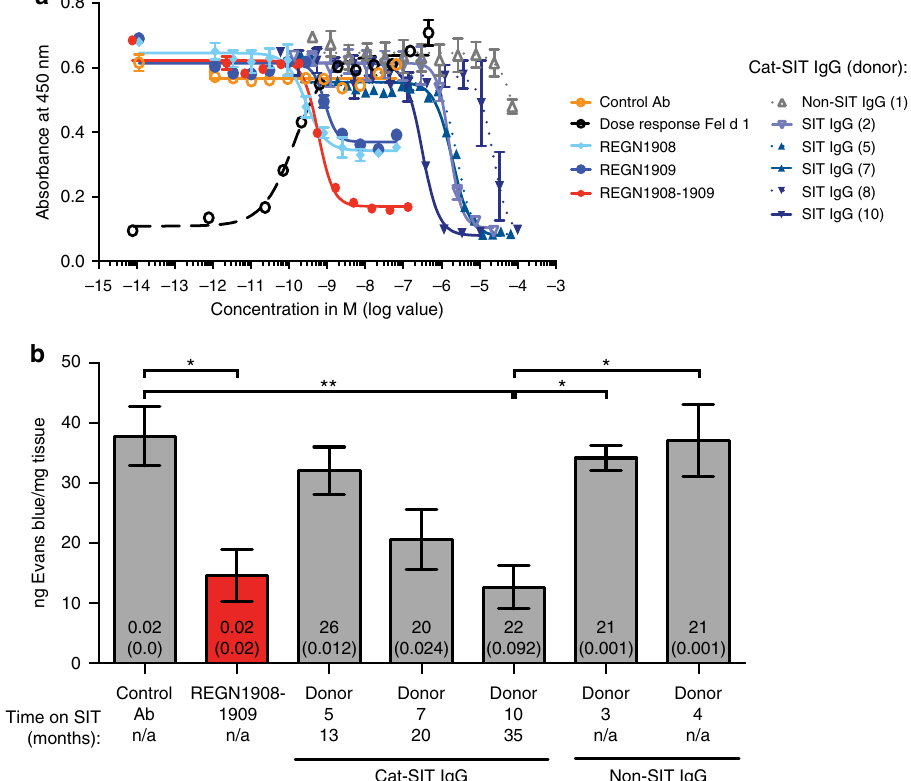
Fig. 4 REGN1908 – 1909 blocks Fel d 1 binding to polyclonal Fel d 1-speci fi c IgE more ef fi ciently than natural IgGs from speci fi c immunotherapy (SIT) patients. a In a blocking ELISA, the ability of REGN1908, REGN1909, REGN1908 – 1909, or Cat-SIT-IgG to block 0.7 nM rFel d 1.mmh from binding to plate- captured Fel d 1-speci fi c IgE from one donor was assessed. A representative experiment using IgE from 1 donor of 3 donors tested is shown. The mean and SD from duplicate wells are plotted. b Balb/c mice were administered subcutaneous (SC) injections of a combination of REGN1908 – 1909 (1:1 ratio, n = 10), an IgG4 P control antibody ( n = 10), or concentrated Cat-SIT-IgG from donor 5 ( n = 9), donor 7 ( n = 10), donor 10 ( n = 10) or Non-SIT-IgG from donor 3 ( n = 10) or donor 4 ( n = 10) prior to the passive cutaneous anaphylaxis model using nFel d 1. Donors 5, 7, and 10 correspond to Donors 2-03(5), 2-05(7), and 2-07(10), respectively in Fig. 1 and Supplementary Table 1. The number per group represents pooled data from two independent experiments. Data are presented as mean ± SE ng of Evans blue extracted per mg of ear tissue is based on the value obtained from each control peanut ear subtracted from the corresponding value from the challenge ear. The total IgG concentration injected (mg), and Fel d 1-speci fi c concentration injected (mg) is represented by the numbers on the bar graphs, with the latter in parentheses. Statistical signi fi cance was determined using the Kruskal – Wallis test followed by Dunn ’ s post hoc test. ** p < 0.01 or * p <